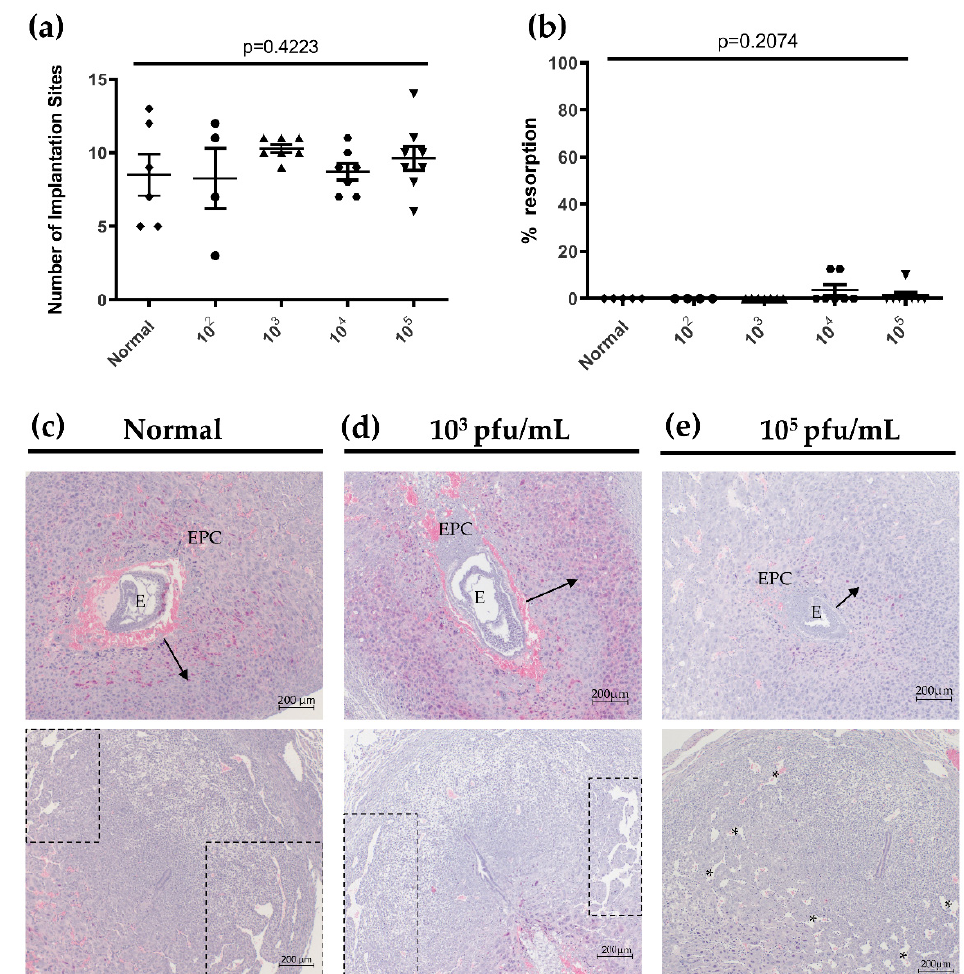
Figure 4. HSV-2 infection does not result in adverse pregnancy outcomes at gd7.5. ( a ) The number of healthy implantation sites in mice infected with 10 2 –10 5 pfu/mL of HSV-2 did not vary significantly from uninfected normal controls at gd7.5 (n = 4–8 mice per group). ( b ) The percent resorption of pregnancies from infected mice did not differ from uninfected controls. Only mice infected with high viral doses (10 4 and 10 5 pfu/mL) had resorptions at gd7.5 (n = 4–8 mice per group). ( c ) Implantation sites from normal mice showed radial trophoblast invasion (arrow) and lateral decidual sinusoid formation (boxes). ( d ) In gd7.5 implantation sites from low dose (10 3 pfu/mL) infected animals, radial trophoblast invasion (arrow) and sinusoid formation (boxes) were similar to controls. ( e ) In high dose (10 5 pfu/mL) infected mice, embryos appeared smaller, trophoblast outgrowth was diminished (arrow), and lateral decidual sinusoids (*) were disorganized compared to control implantation sites. EPC: ectoplacental cone; E: embryo. Data expressed as mean ± SEM. In contrast to gd7.5 mice, at gd12.5 aberrant pregnancy outcomes became apparent